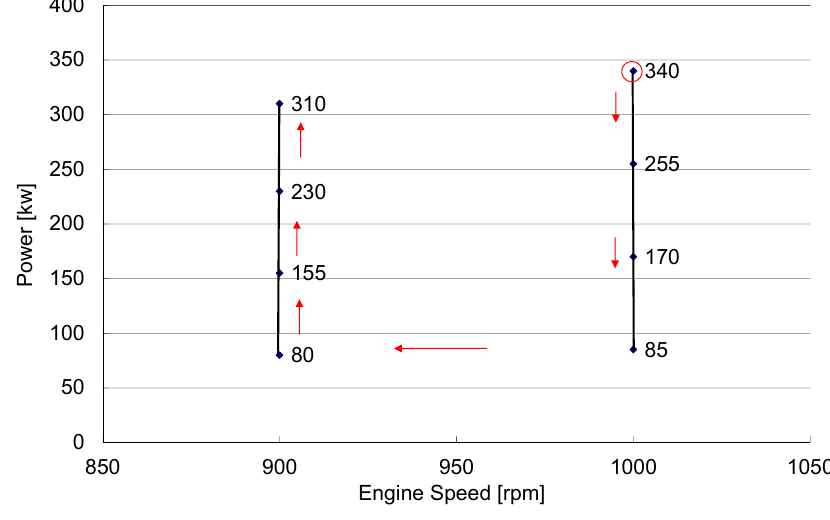
Figure 3. Map of measured